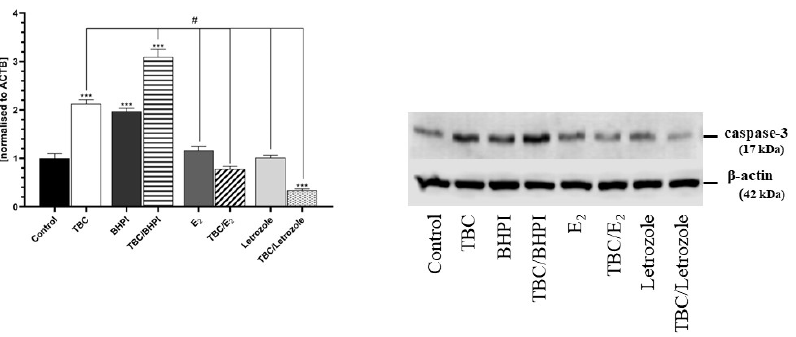
Figure 4. Effect of 10 µM TBC and TBC in the cotreatment (BHPI—10 µM, E 2 —100 nM, letrozole— 1 µM) on the caspase-3 protein expression level in the GC-1 spg cell line after 48 h exposure. Data are expressed as means ± SD of three independent experiments, each conducted in six replicates per treatment group. *** p < 0.001 vs. the vehicle control; # p < 0.05 vs. cells treated by TBC alone.